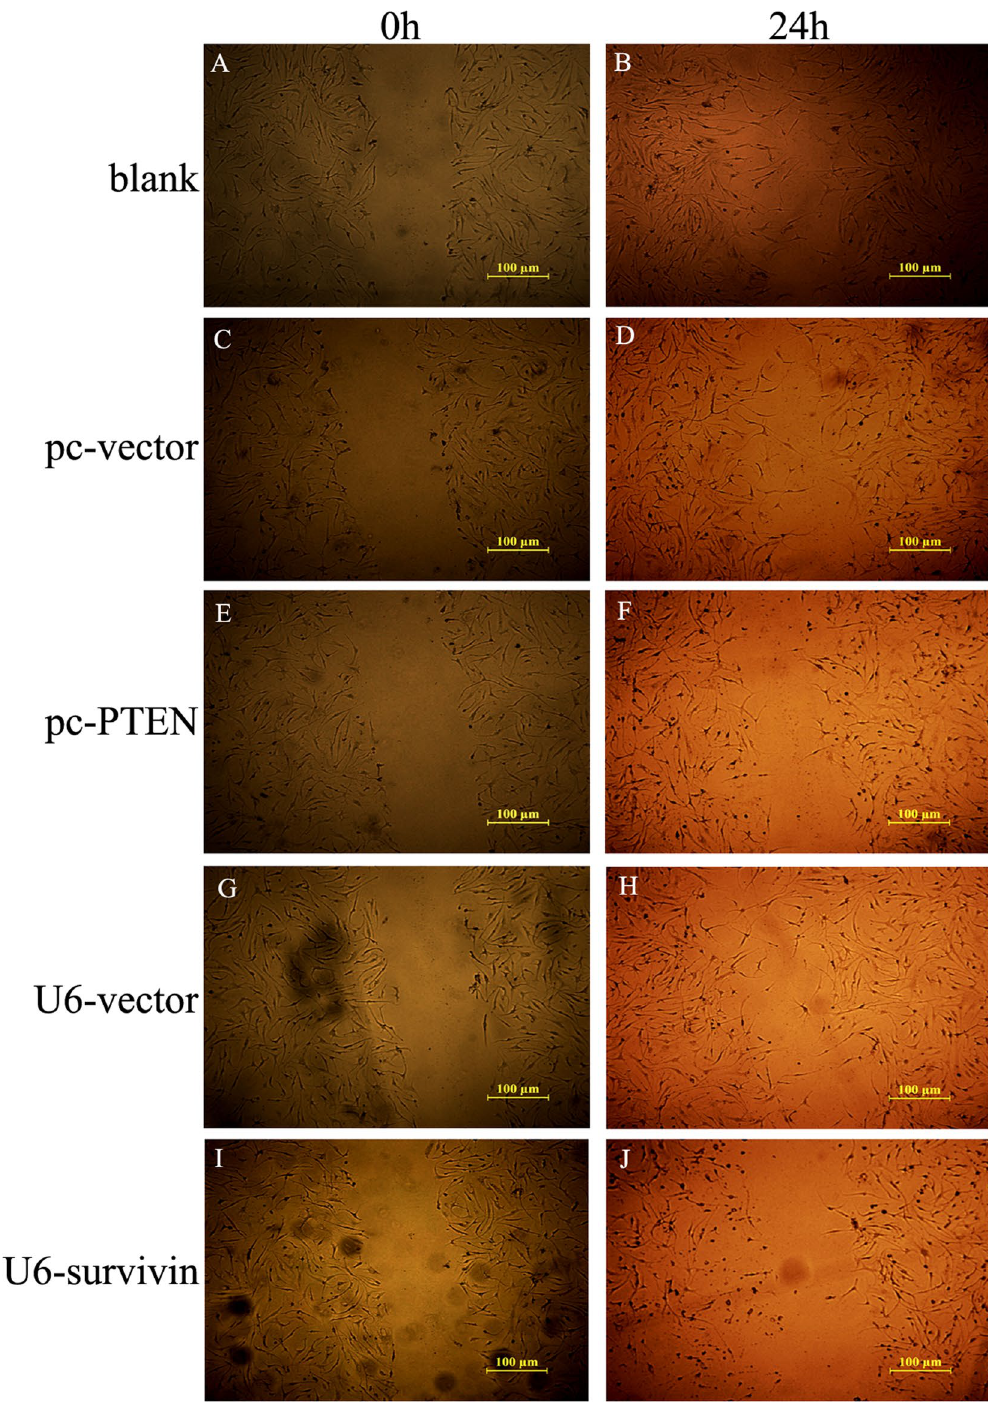
Figure 5. Representative images of cell density in wound-healing assay. ( A , C , E , G and I ) were representive pictures of wound healing assay at 0 h. ( B , D , F , H and J ) were representive pictures of wound healing assay after 24 h. ( A and B ) Showed the RA-FLS of blank. ( C and D ) Showed the RA-FLS of pc-vector control transfection. ( E and F ) Showed the RA-FLS with pc-PTEN over-expression. ( G and H ) Showed the RA-FLS of U6-vector control transfection. ( I and J ) Showed the RA-FLS with survivin